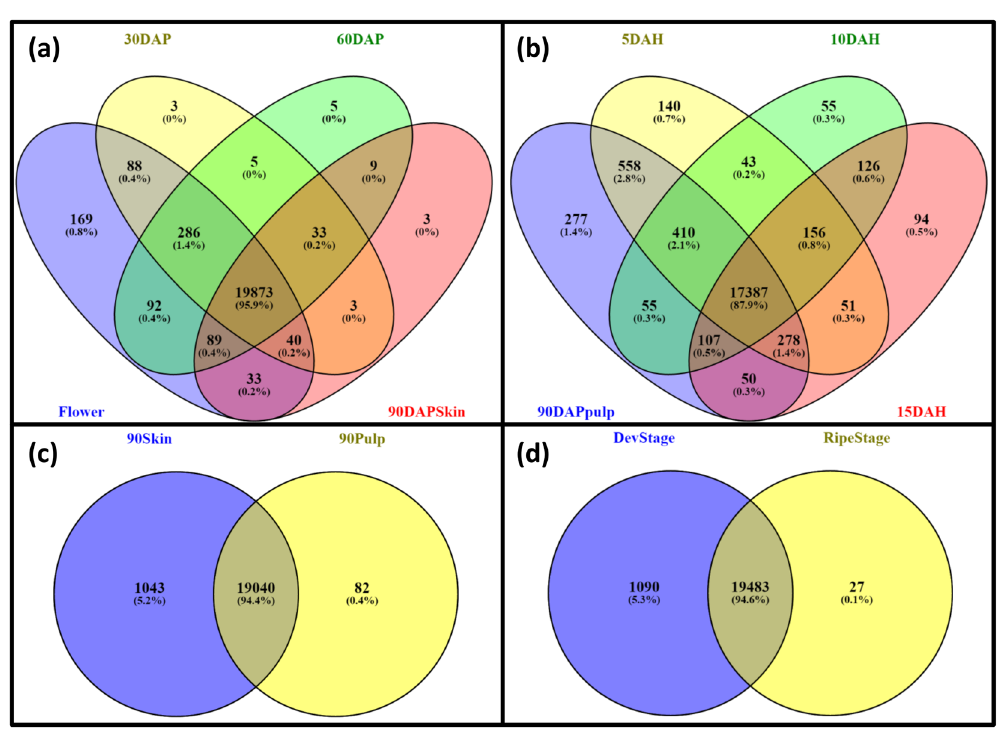
Figure 2. Venn diagrams representing common and distinct transcripts through various comparisons ( a ) Flower, 30 DAP, 60 DAP and 90 DAP skin; ( b ) 90 DAP pulp, 5 DAH, 10 DAH and 15 DAH; ( c ) 90 DAP pulp and 90 DAP skin and ( d ) fruit developing and ripening